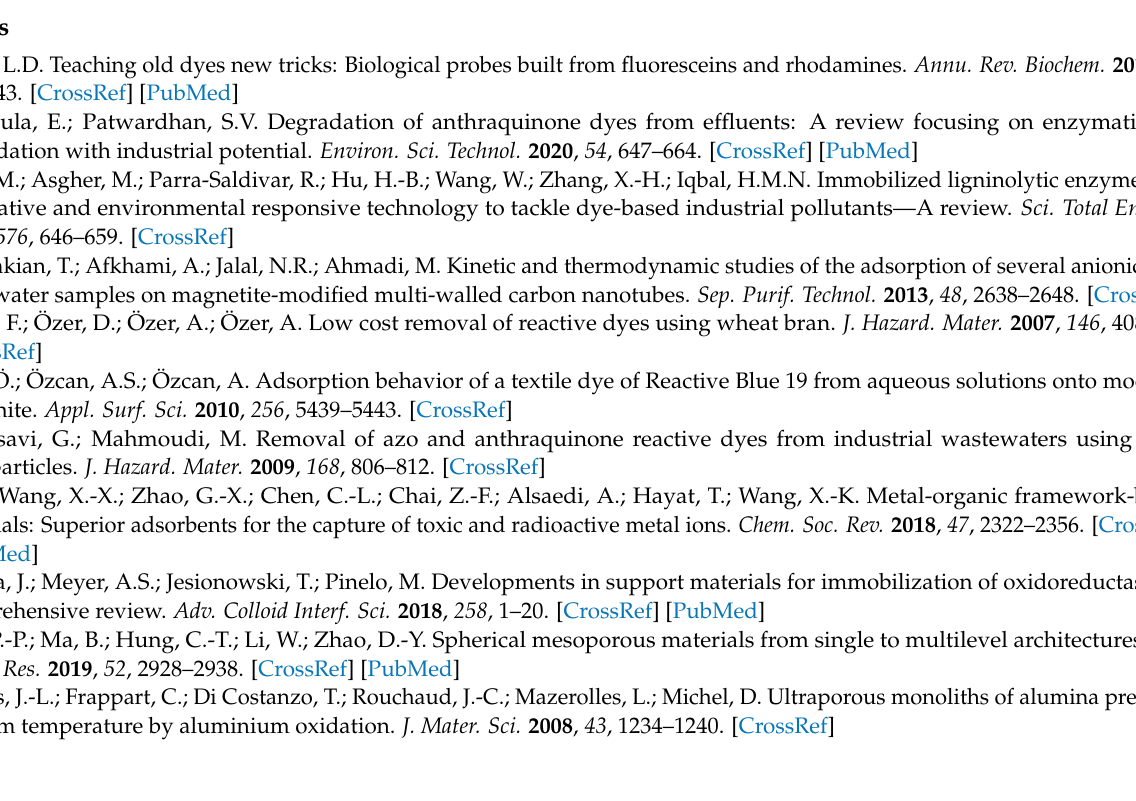
mg · m − 2, Figure S8: EDX spectra of UPA( θ ) powders before and after RBBR adsorption, Figure S9: SEM images of UPA( θ ) powders before and after RBBR adsorption, Figure S10: The pH variation after RBBR adsorption equilibrium, Figure S11: Zeta potential values of UPA( γ ), UPA( θ ), and UPA( α